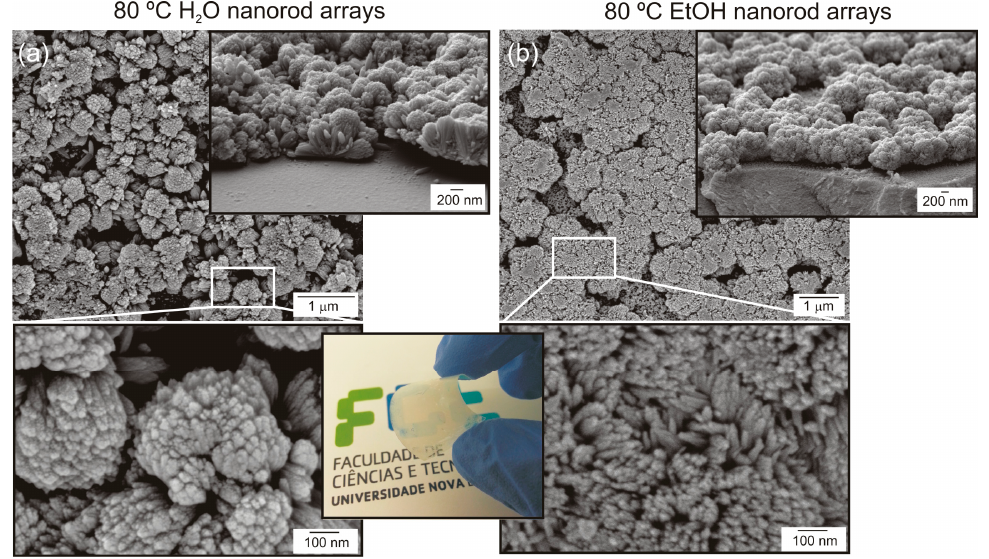
Figure 4. ( a ) Bright field TEM image of the TiO 2 structure detected at the 80 °C H 2 O nanorod spheres; ( b ) Ring diffraction pattern confirming the TiO 2 brookite phase (TiO 2 brookite simulation is included). EDS analyses were carried out in the material cross ‐ sections, which revealed homogeneous distributions of Ti and O in all materials produced (see Figure S2). The presence of ZnO (Zn map) could not be confirmed through EDS due to the reduced thickness of the film [64].